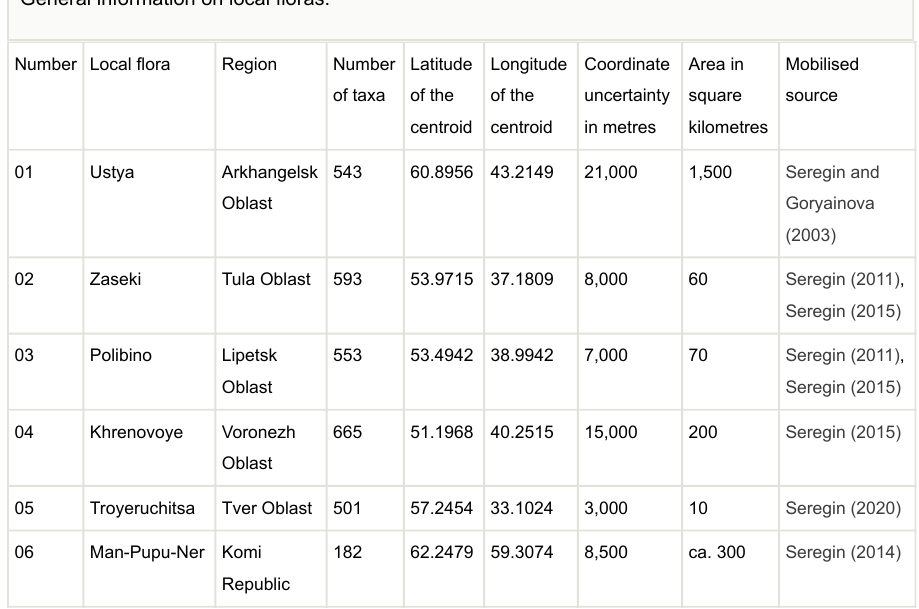
General information on local